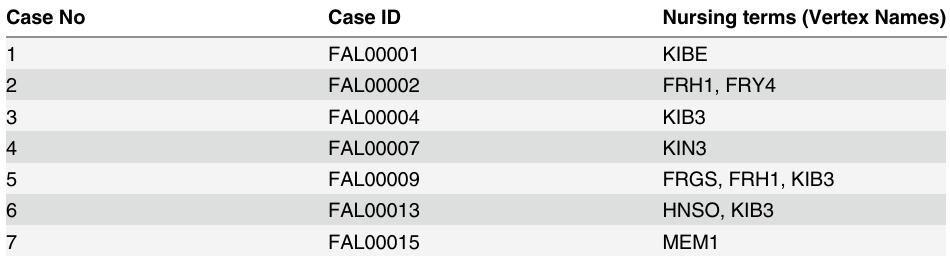
Table 2. Different cases for patient PAT00001 and the elements of the vertex alphabet.